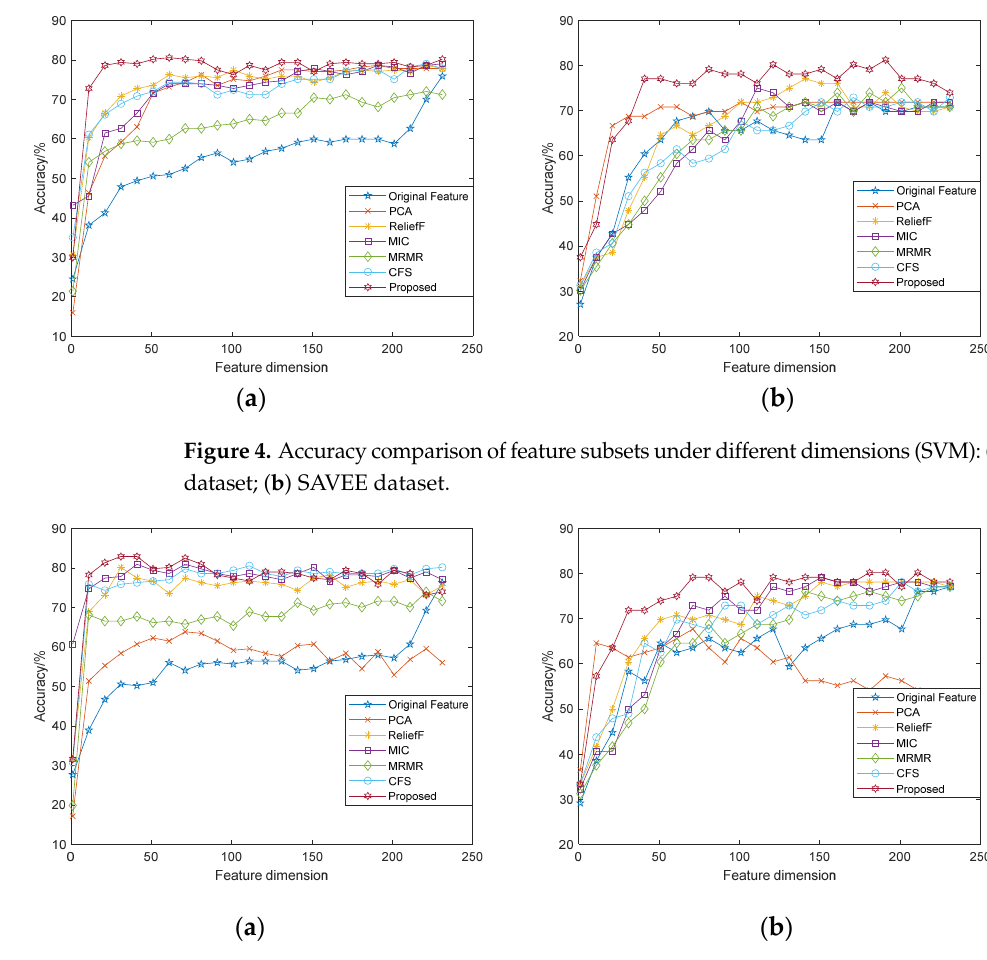
Figure 5. Accuracy comparison of feature subsets under different dimensions (RF): ( a ) eNTERFACE’05 dataset; ( b ) SAVEE dataset. Table 1. Highest recognition rate for each method (%).